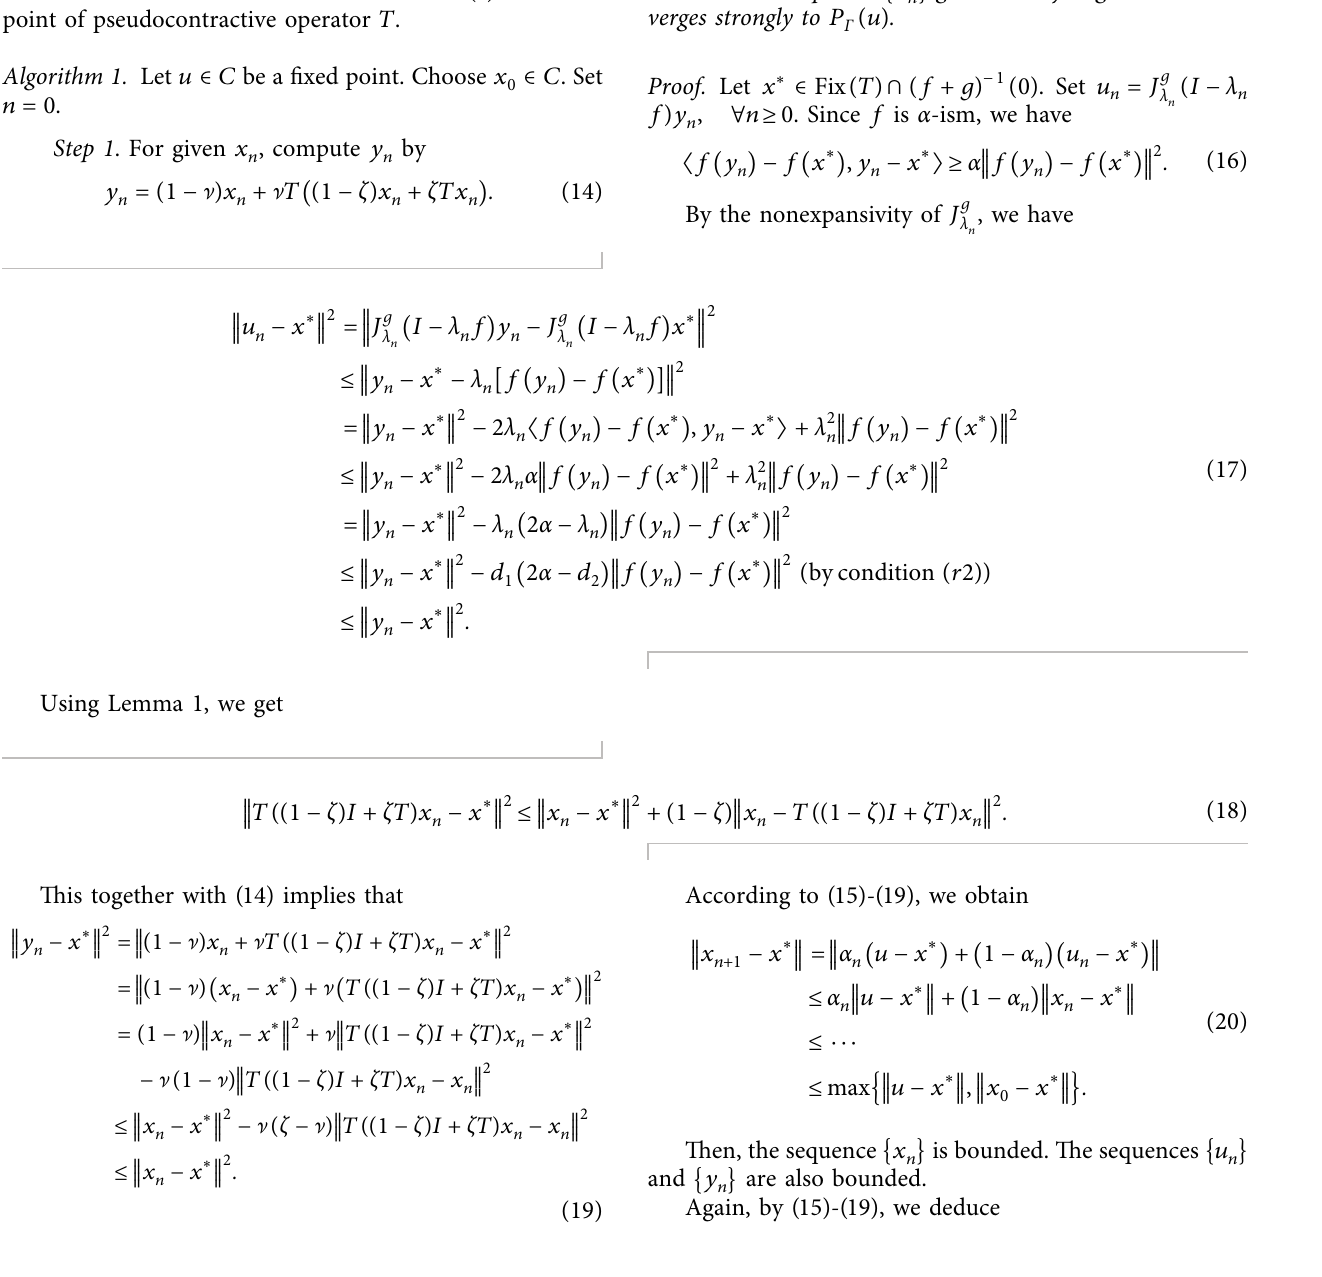
Algorithm 1. Let u ∈ C be a fixed point. Choose x n �